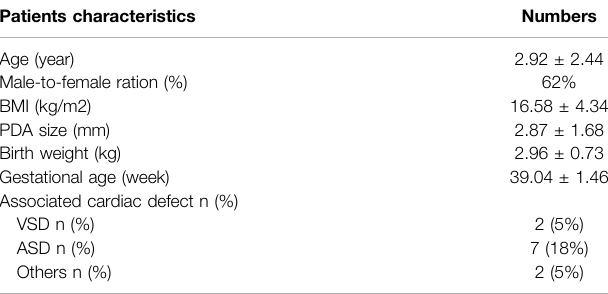
TABLE 1 | Characteristics of 39 PDA patients. Patients characteristics